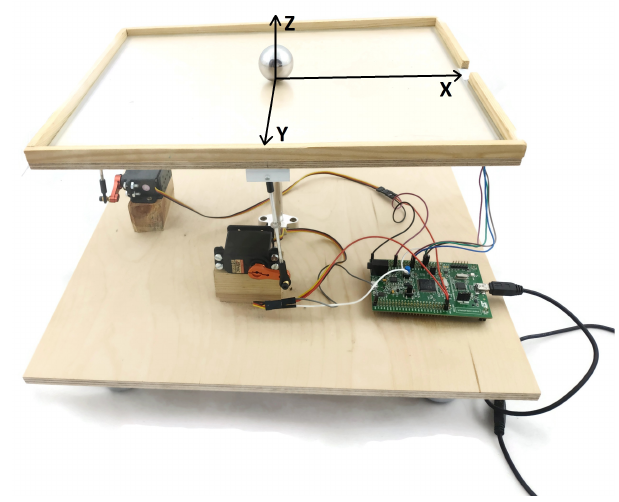
Figure 1. The ball-on-plate process The process has two manipulated and two controlled variables. The Pulse Width Modulation (PWM) signals are used to control the digital servomotors. The plate rotates around the X and Y axes. Two signals that define the ball position on the top panel are the controlled variables. The actual ball position on the resistive touch panel is determined by two Analog to Digital Converters (ADCs). The STM32 F401C Disco microcontroller development board is used for implementation of control algorithms and communication with the PC computer (it is only used for saving the data and plotting the